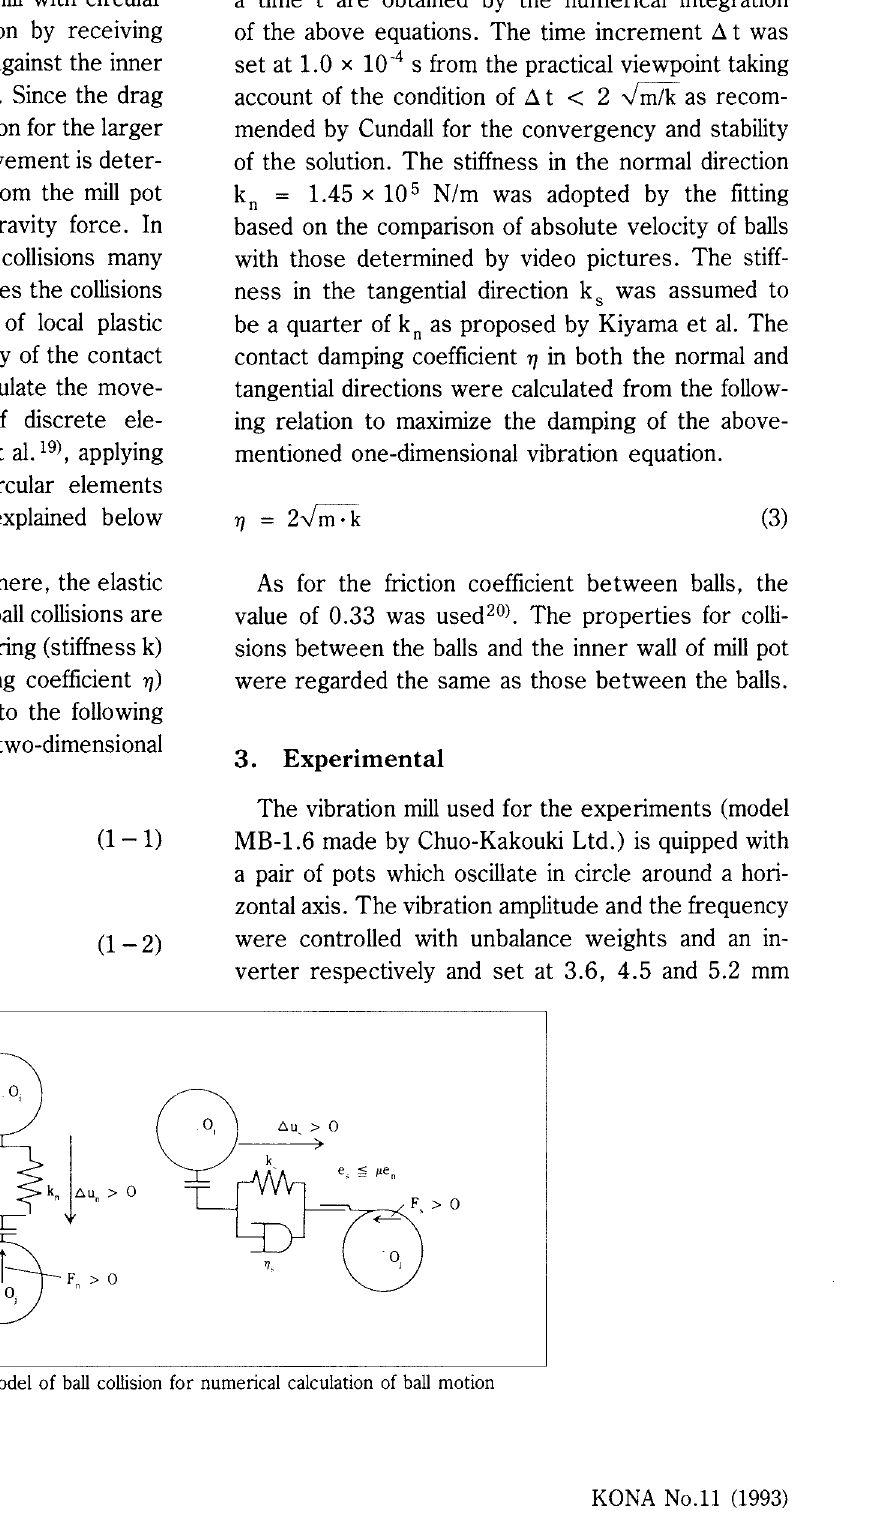
Fig. 1 Model of ball collision for numerical calculation of ball